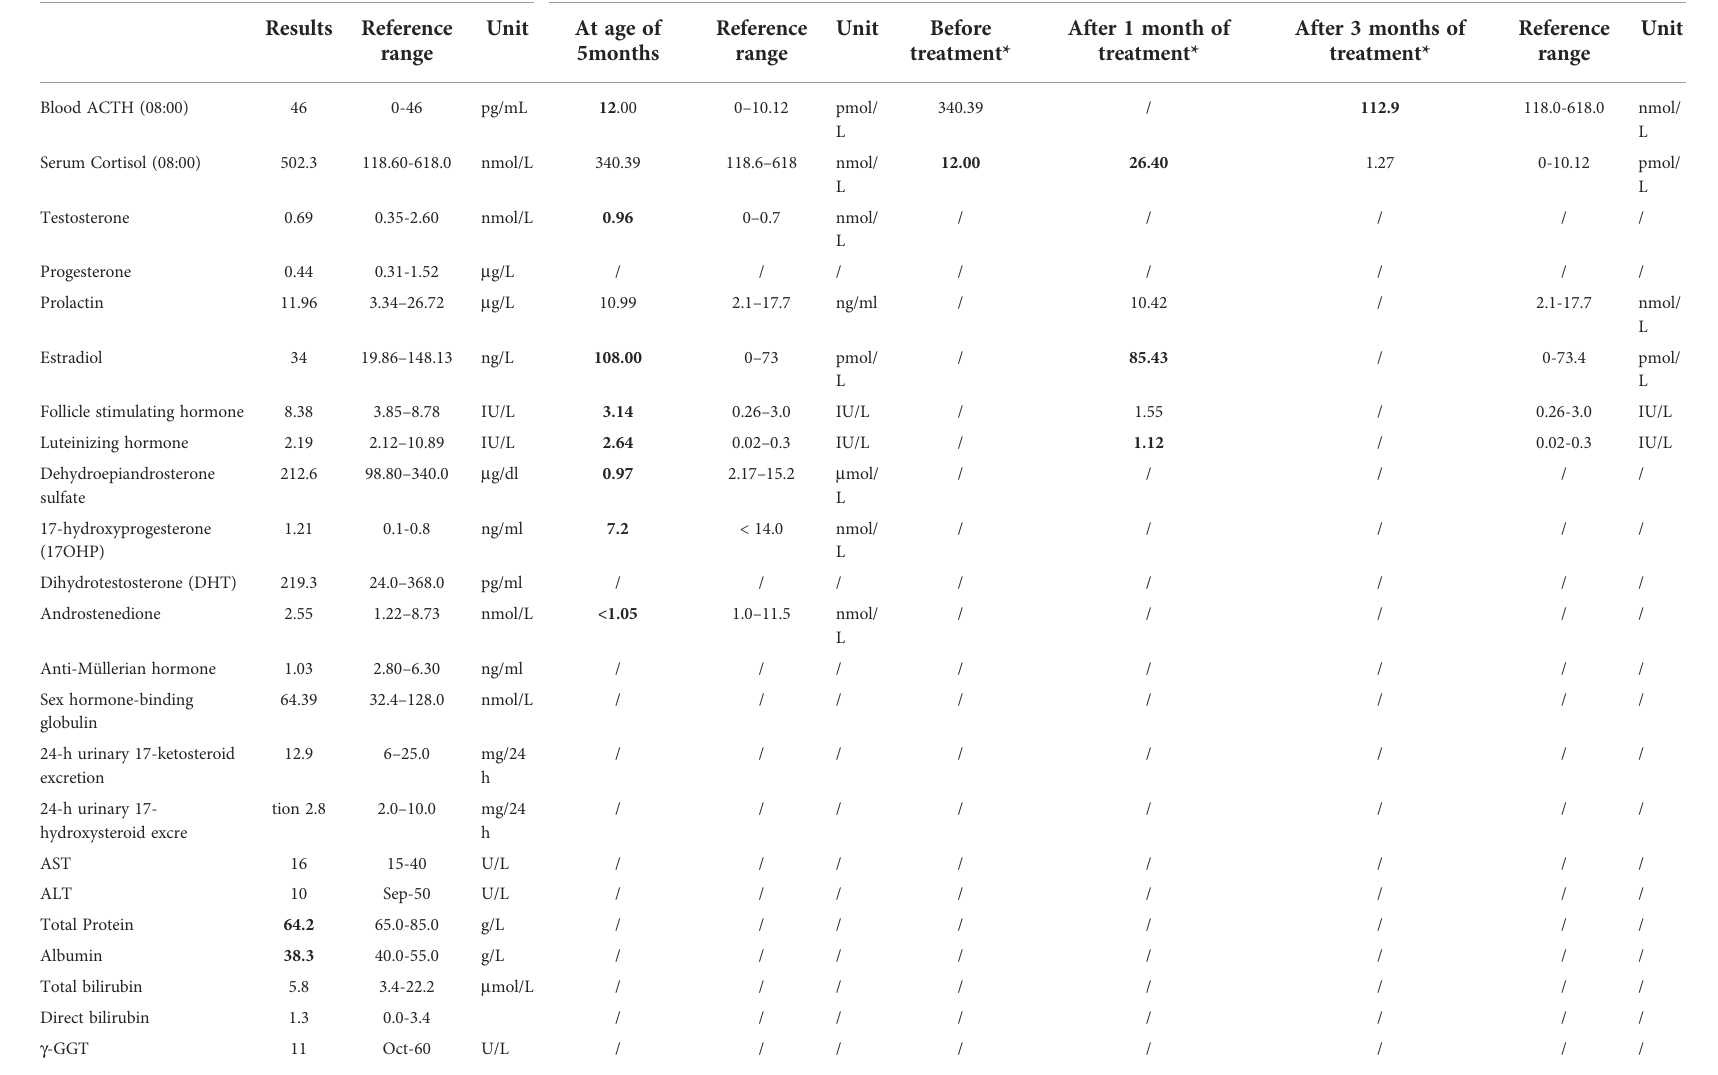
TABLE 1 Biochmeical examination results of case 1 and case